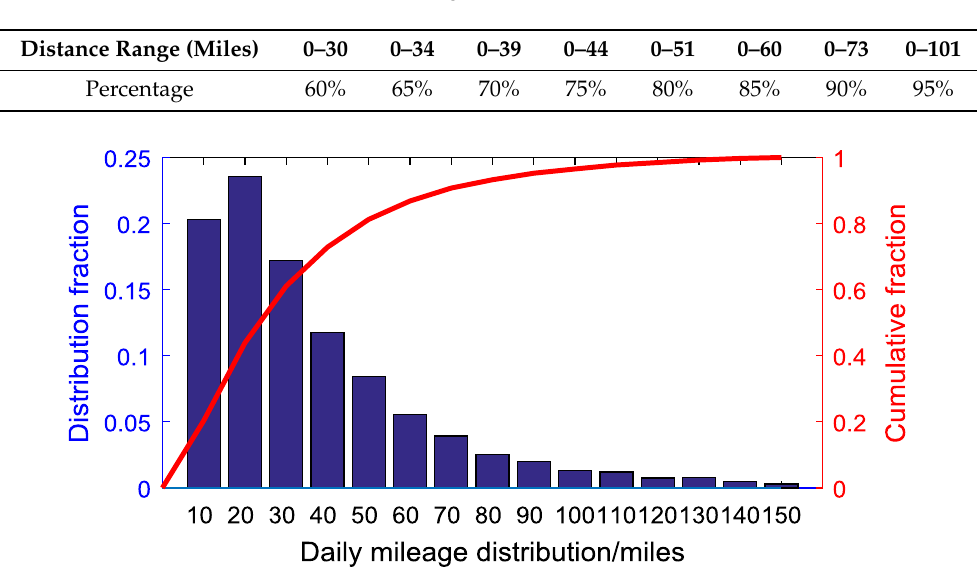
Table 1. Driving distance distribution.